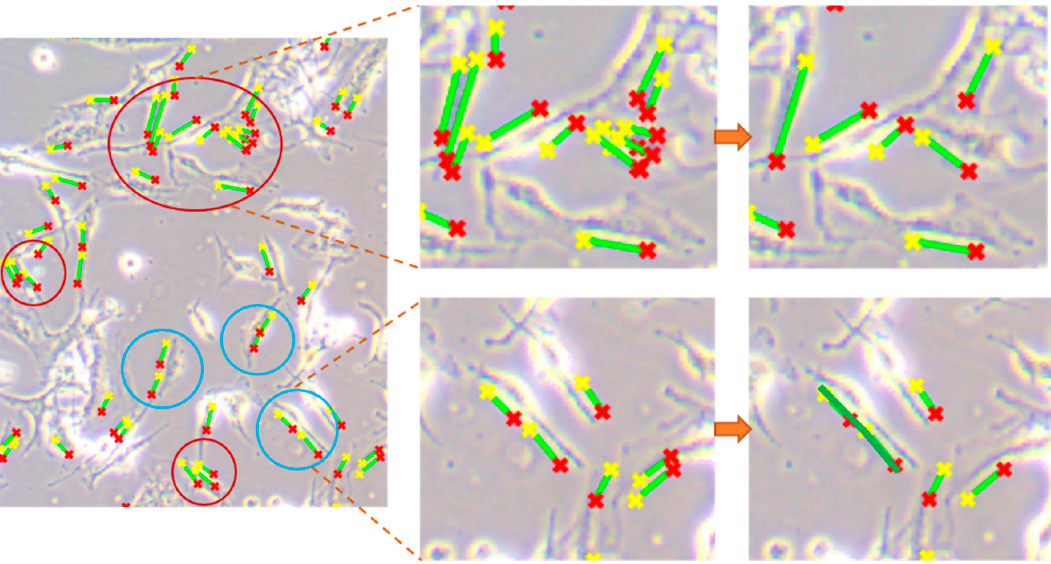
Figure 2. Two kinds of detection before and after post-processing. The red circles represent excessive lines for marking cells, and the blue circles represent lines with points of intersection.